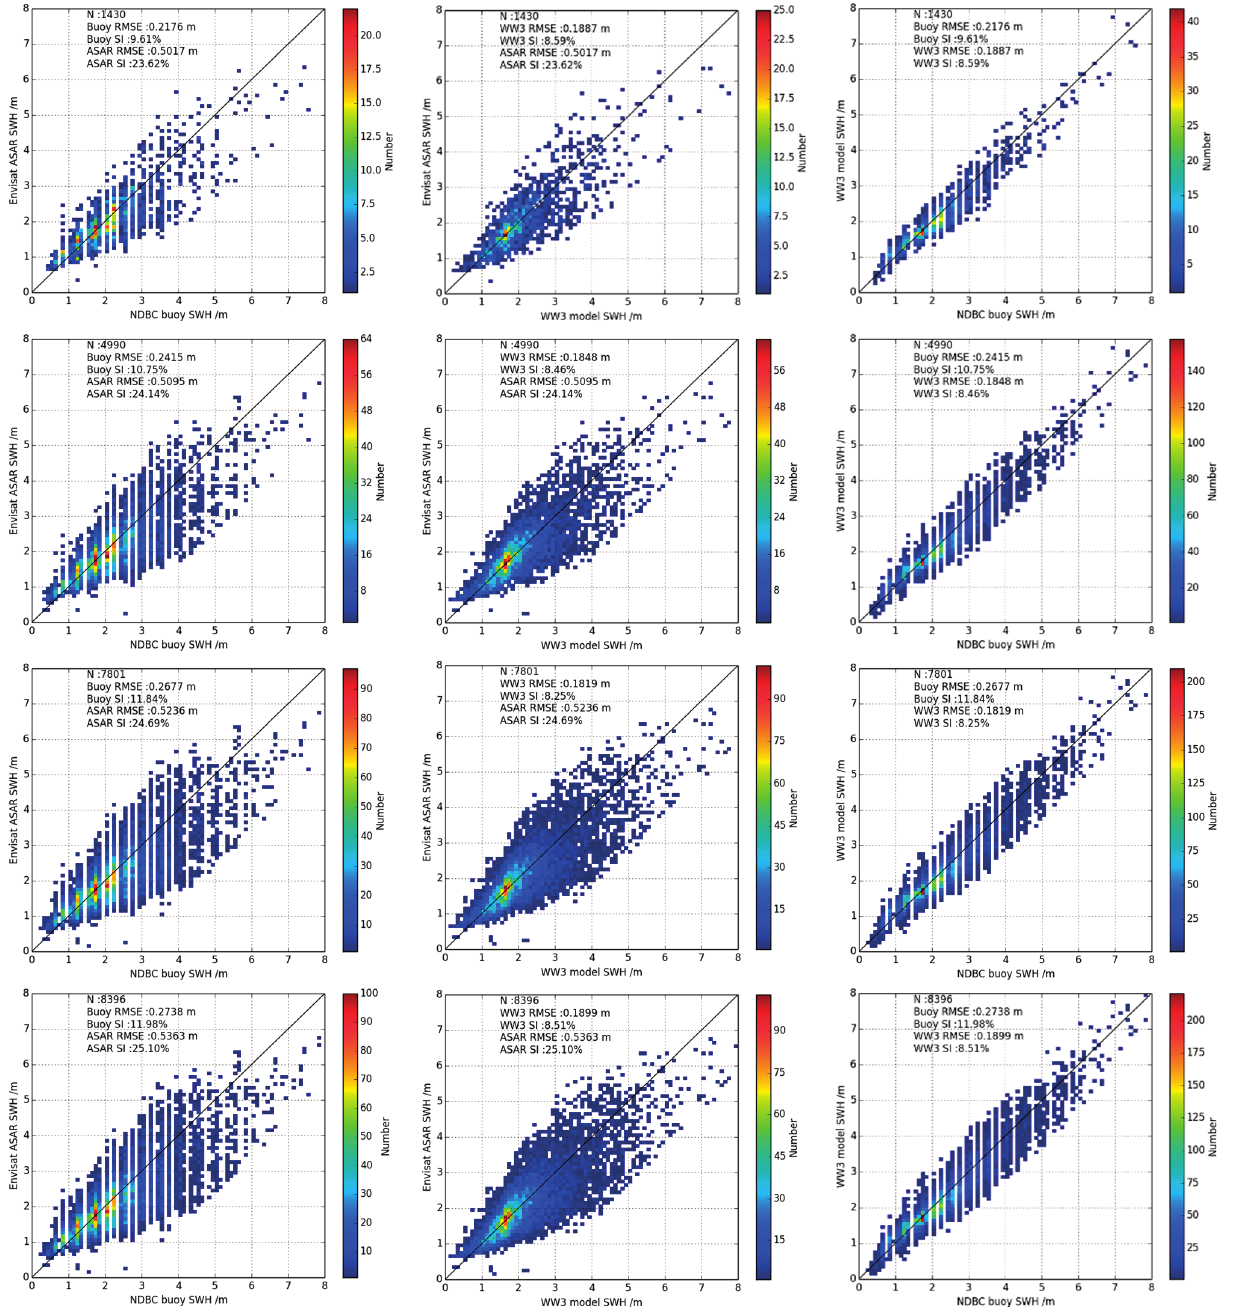
Figure 6. As in Figure 5, but for datasets with 54 buoys only in the deep and open